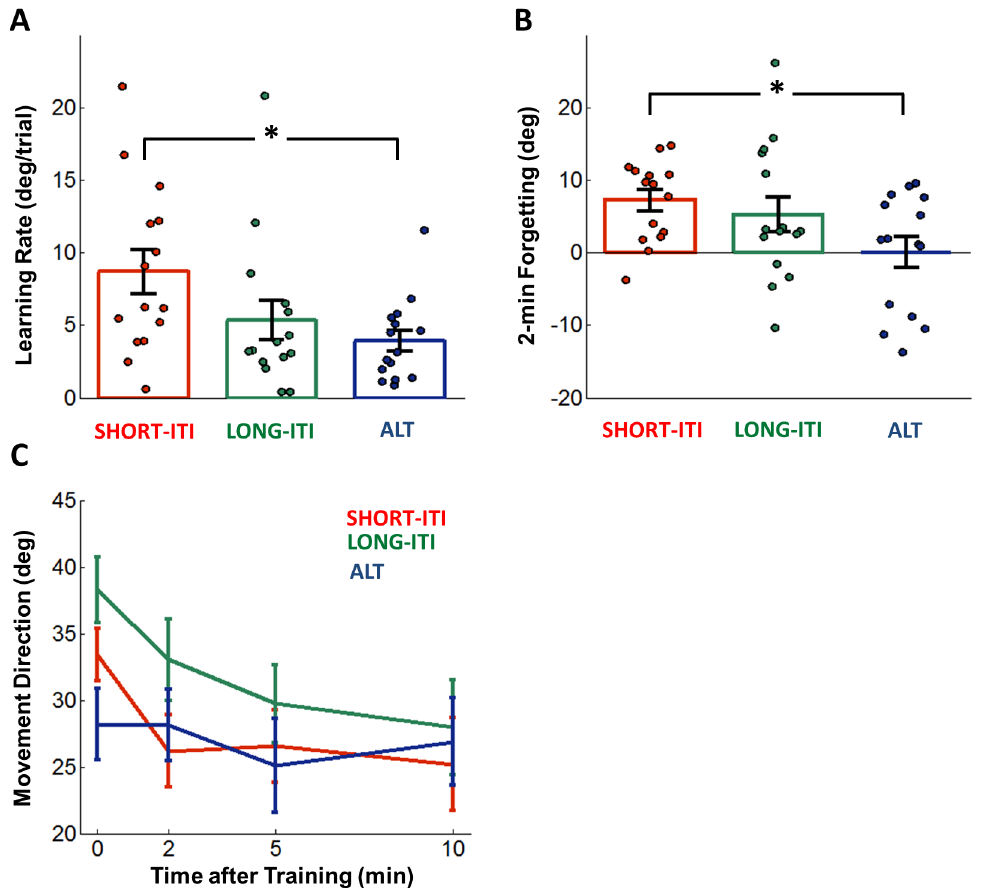
Fig 3. Comparison of initial learning and retention. A : Initial learning rates (performance increase per trial) obtained from the initial 15 trials in the training block. B : Forgetting in the two minute post-training. Forgetting was measured as a difference between zero and two minute retention tests post-training (see Methods). C : Overall retention in 0, 2, 5, and 10 minute post-training. In Fig 4 A and 4 B , circles indicate performance of individual subjects.